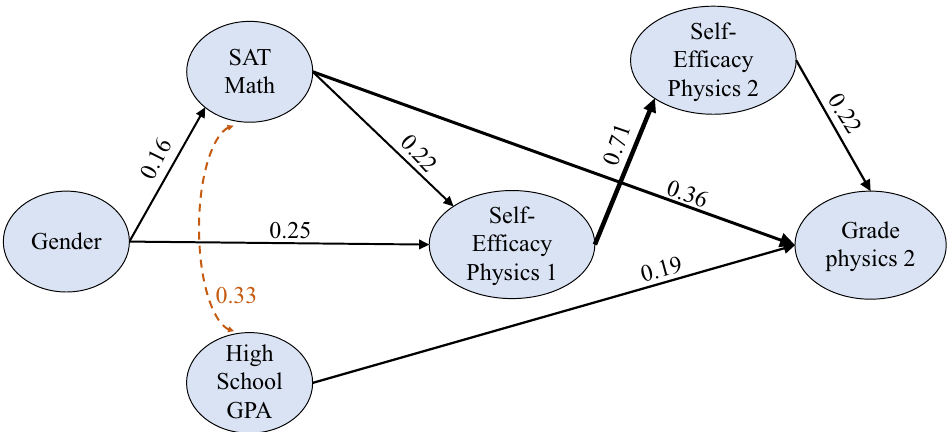
FIG. 6. Result of the path analysis part of the SEM without grade in physics 1 between gender and physics 2 grade through students ’ self-efficacy for model 5. The line thickness indicates the relative magnitude of β values. The dashed lines indicate covariances between constructs. All p values are for p < 0 . 001